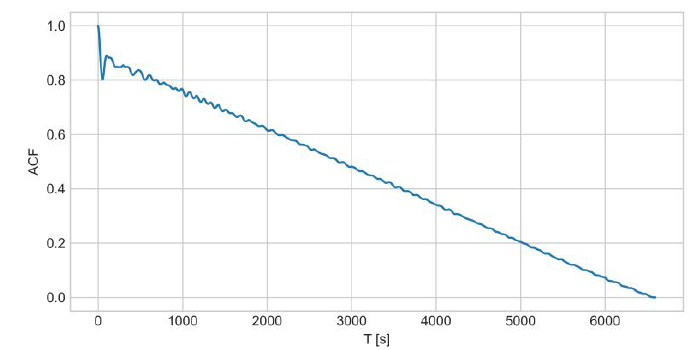
Figure A4. Autocorrelation function of the raw force signal over 61 actuation cycles for the 8 wt.% diamond nanoparticle-based filler silicone/ethanol composite.